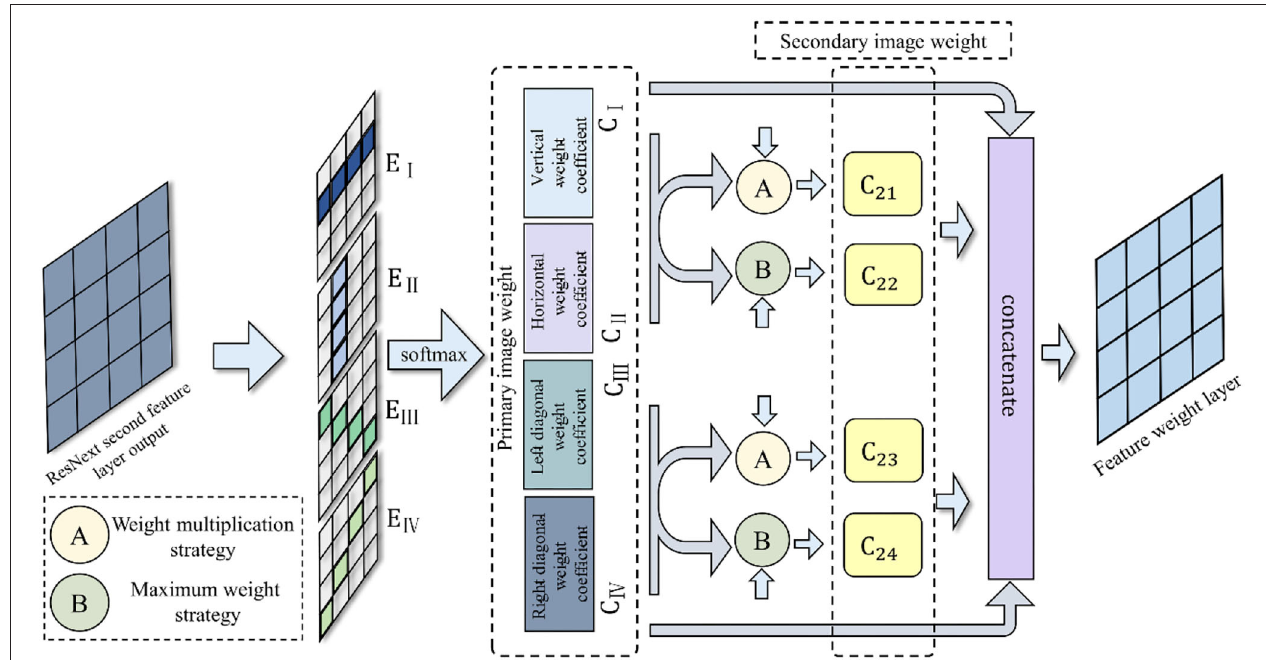
FIGURE 5 | Algorithm block diagram of MDAM.